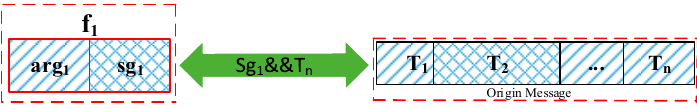
Figure 6. Example of token location in the first category.